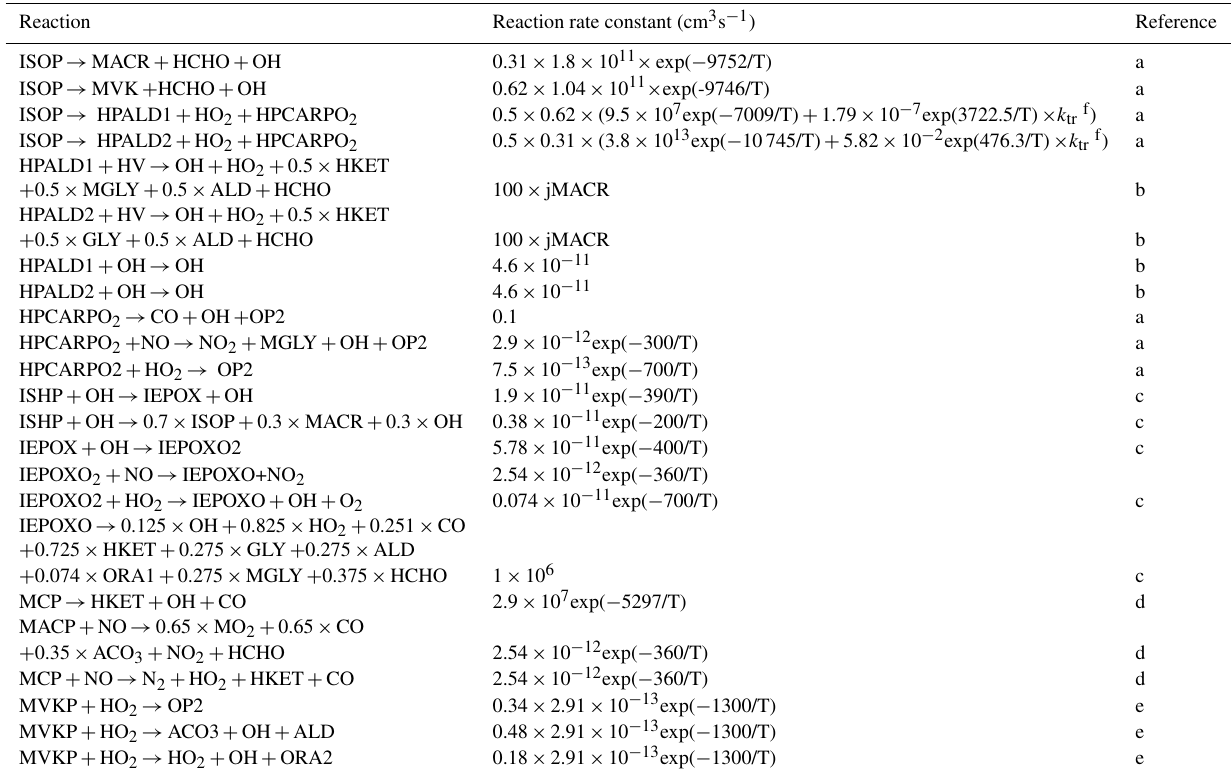
Table 4. Isoprene oxidation mechanism replacing the isoprene chemistry in RACM 2. Reaction